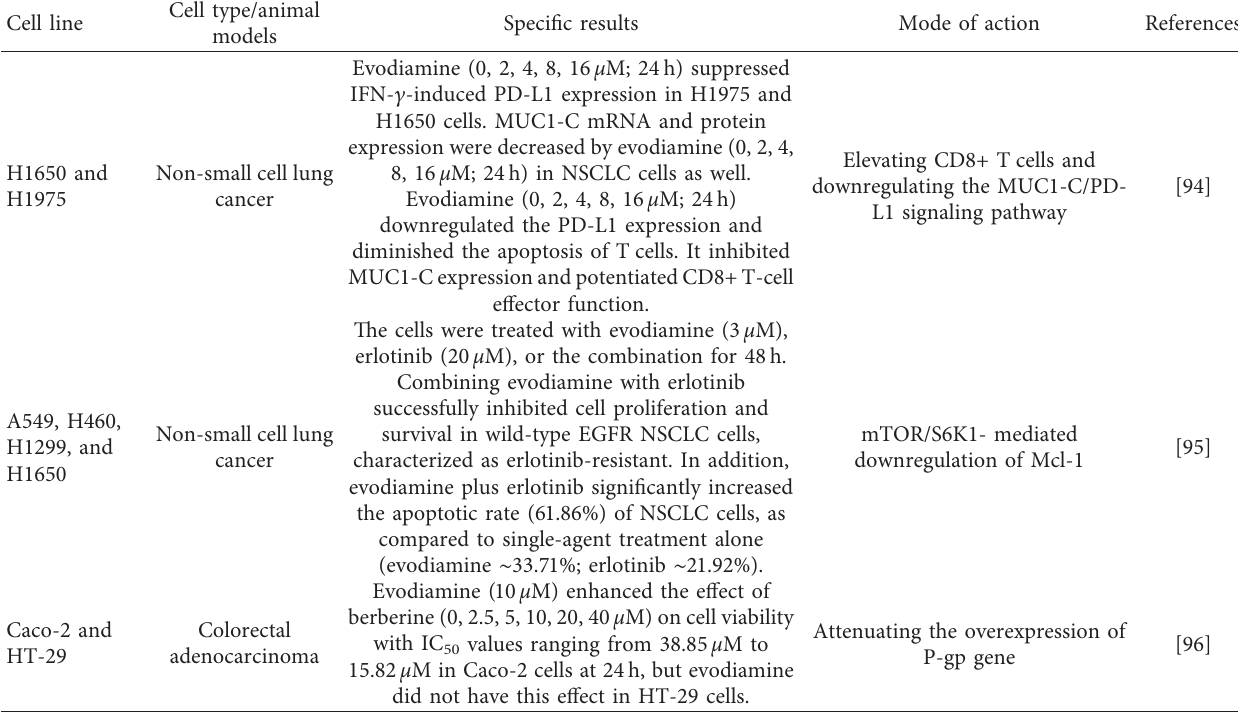
Table 5: Antitumor immunotherapeutic mechanisms and antitumor drug combinations involving evodiamine. Cell